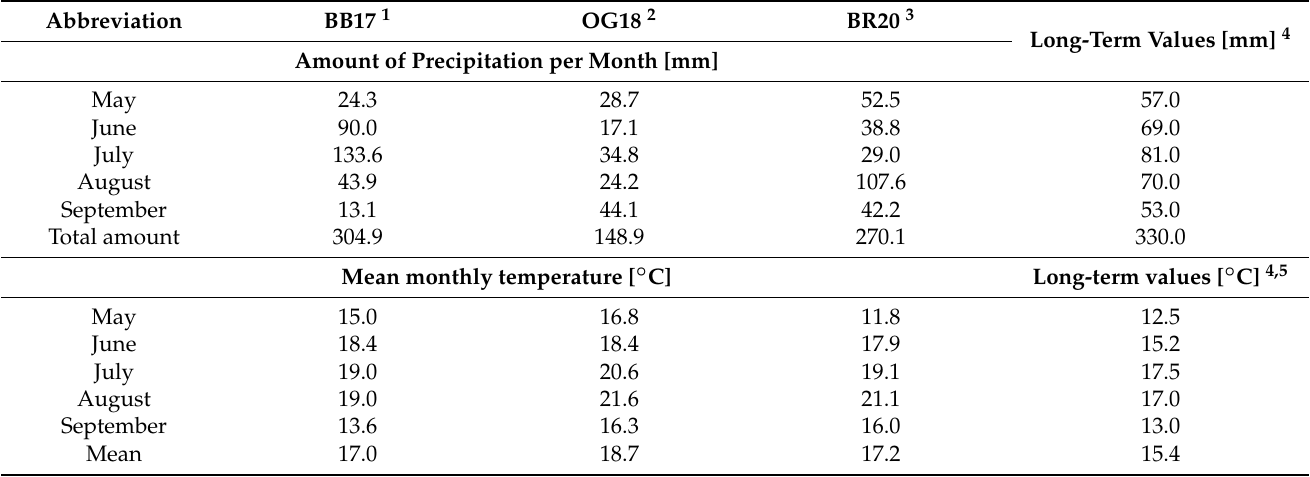
Table 2. Amount of precipitation [mm] and mean monthly temperature [ ◦ C] during Ens and long- term values for the